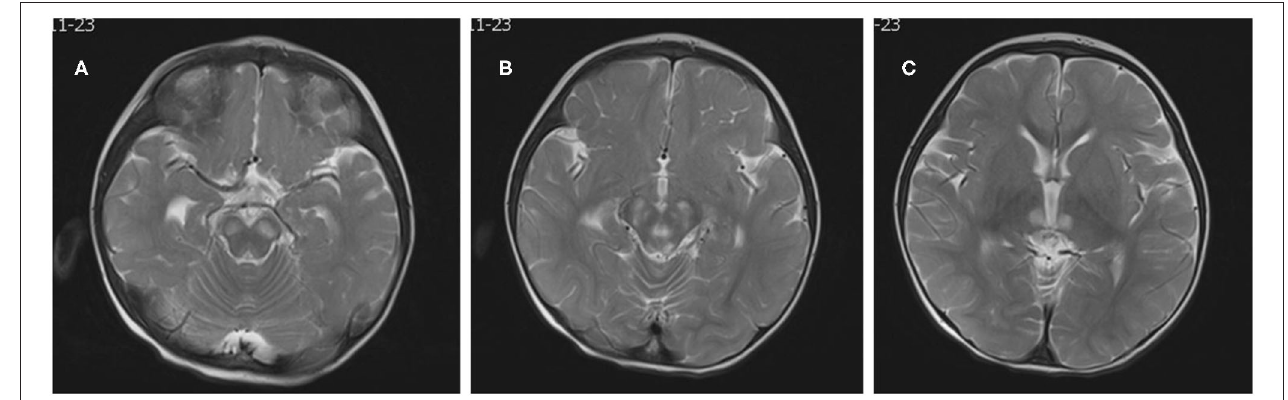
FIGURE 1 | Neuroradiological features. Brain MRI showed bilateral, symmetric signal abnormalities in the basal ganglia, and brain stem ( A–C : T2-weighted